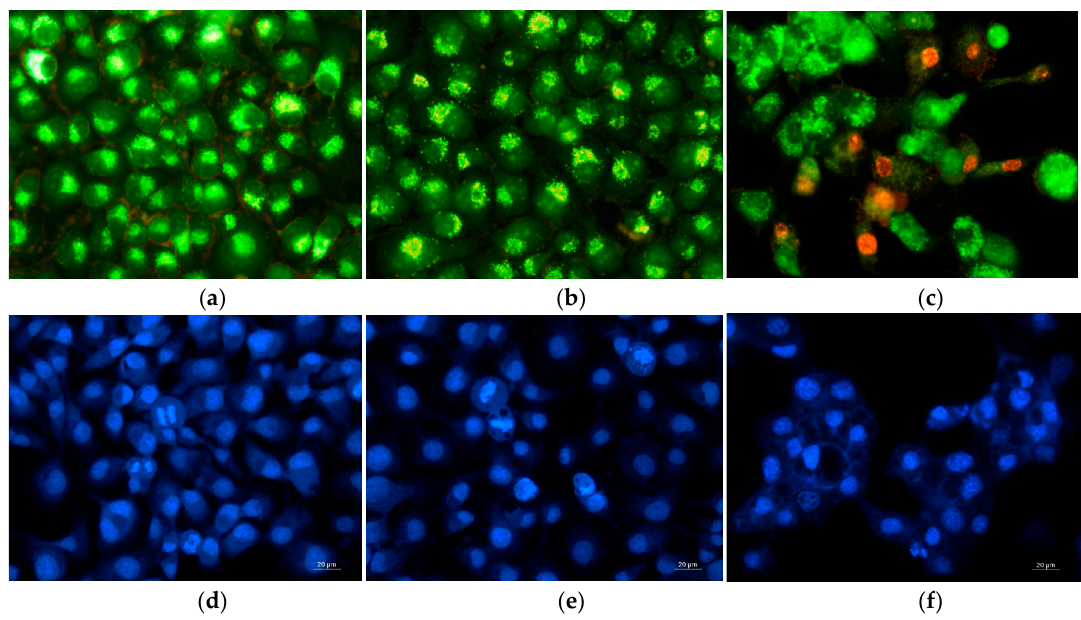
( d – f ) HeLa cancer cells incubated for 24 h ( a , d ) untreated cells; after incubation with: ( b , e ) CA / PEG Figure 9. Fluorescence micrographs of AO and EtBr double-stained (a–c) and stained with DAPI (d–f) HeLa cancer cells incubated for 24 h (a and d) untreated cells; after incubation with: (b and e) mat, ( c , f ) CA / PEG / QUE mat; bar = 20 µ m. CA/PEG mat, (c and f) CA/PEG/QUE mat; bar = 20 µm.